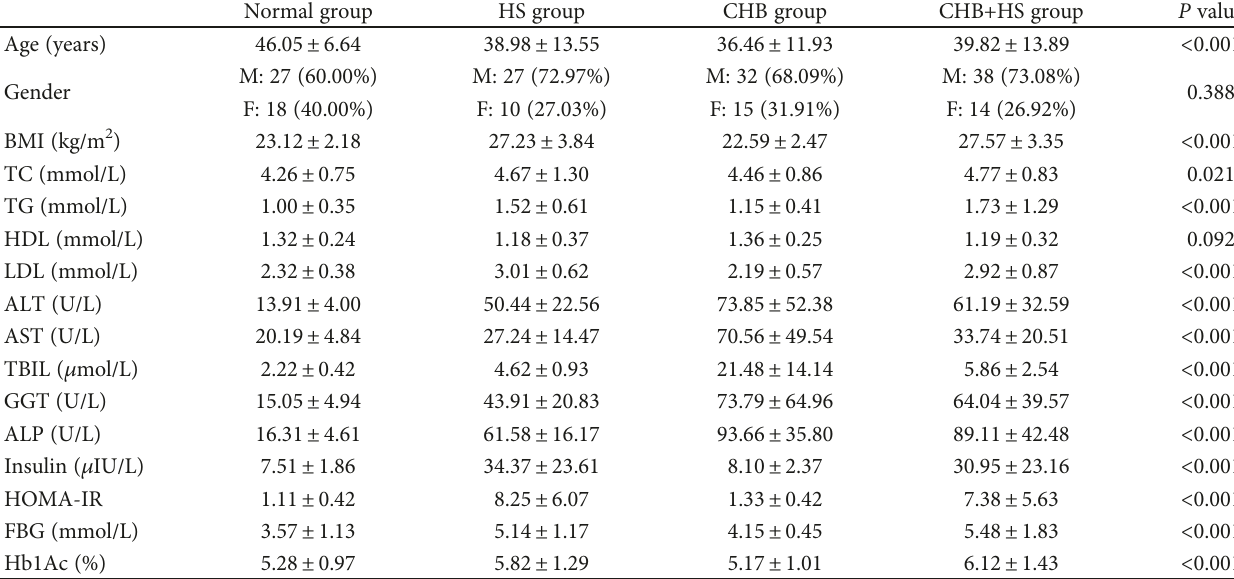
Table 1: Demographic, anthropometric, and clinical data. Normal